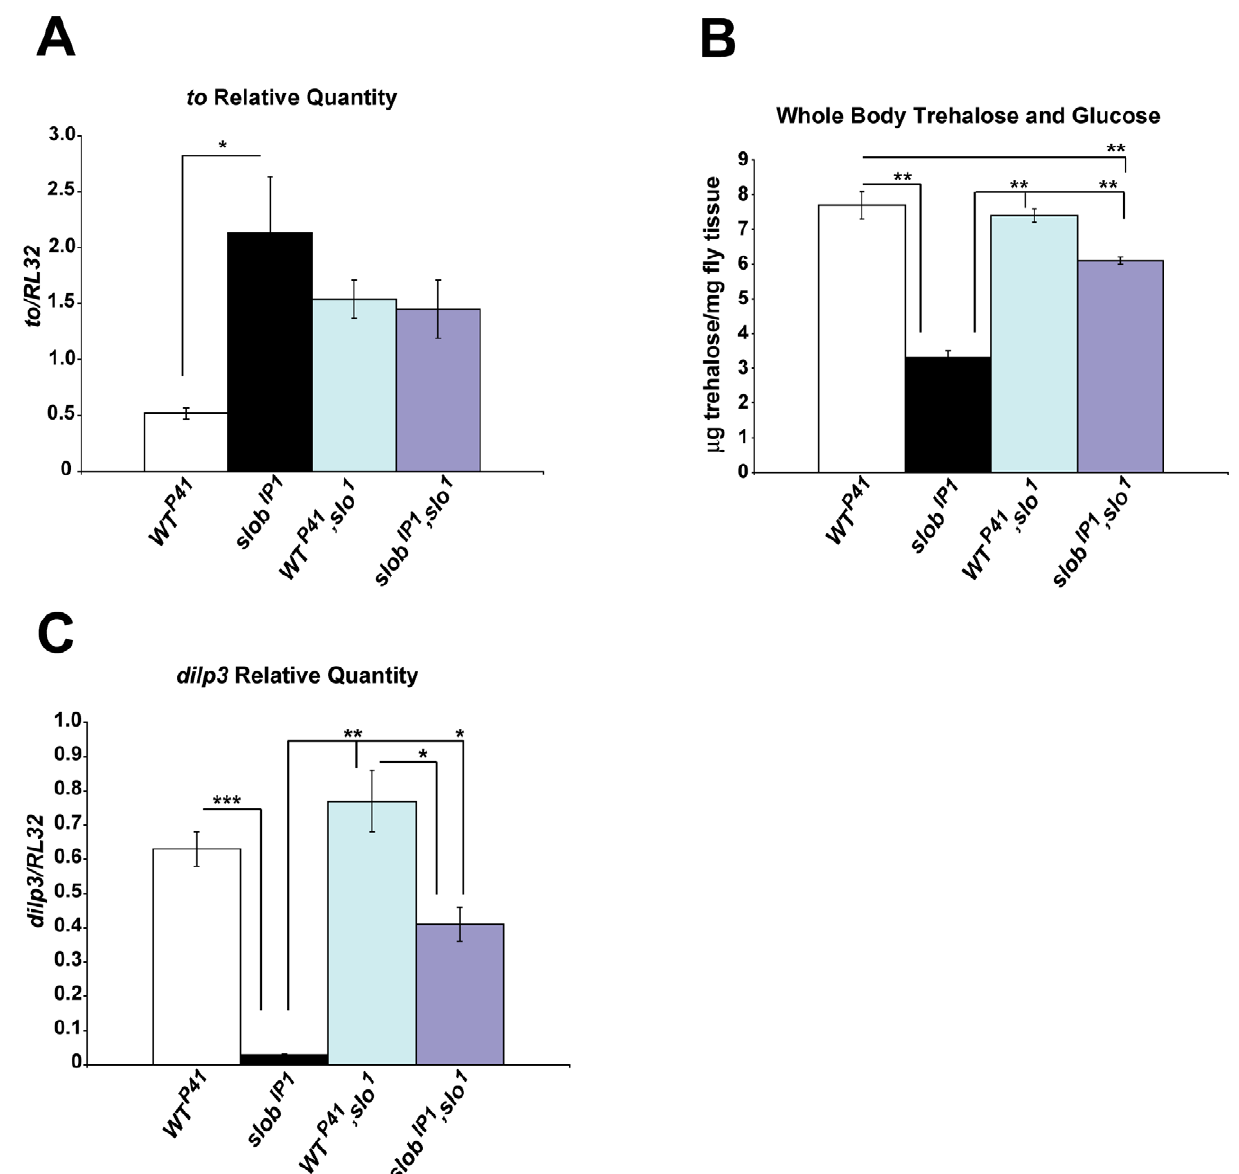
Figure 7. The effects of SLOB on gene expression and metabolism require SLO. A, Relative to transcript levels in fly heads were measured by qPCR. WT P41 ,slo 1 and slob IP1 ,slo 1 express equivalent amount of to in fly heads. B, Whole body trehalose plus glucose levels were measured in flies after fasting. Stored trehalose plus glucose levels are significantly decreased in slob IP1 flies compared to WT P41 ,slo 1 or slob IP1 ,slo 1 flies. C, The reduction in dilp3 levels is attenuated in slob IP1 ,slo 1 fly heads. Results are a summary of a minimum of three ( A, C ) or 13 samples ( B ) (mean 6 SEM). * indicates p , 0.05, ** indicates p , 0.01, *** indicates p , 0.001, One-way ANOVA with Bonferroni post-test.